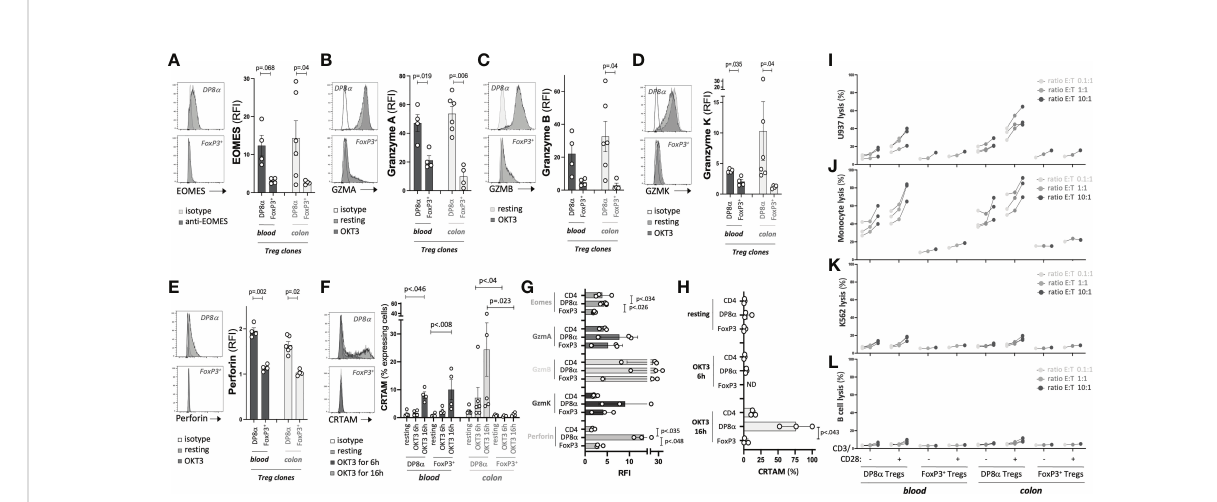
FIGURE 4 DP8 a Tregs can kill myeloid cells. (A , F) Clone expression of EOMES (A) Granzyme A (B) Granzyme B (C) Granzyme K (D) Perforin (E) measured by intracellular labelling following or not activation for 6h and cell surface expression of CRTAM (F) following or not activation for the indicated time. Clones were activated with coated 0.5 m g/ml OKT3. (G, H) PBMCs from 3 HD were OKT3-stimulated for either 6h and stained intracellularly for EOMES, Granzymes A, B, K and Perforin (G) or 6h and 16h and stained for CRTAM (H) . Expression of these proteins is shown for indicated T cell subsets. (I - L) Indicated target cells were co-cultured with blood- and colon-derived DP8 a and FoxP3 + Treg clones (stimulated or not with CD3/CD28 beads) at indicated ratios. Cell death was measured as described in the Methods ’ section. Paired 2-sided t- tests were used for single comparisons, while one-way ANOVA followed by Dunn ’ s multiple comparison tests were performed for 4F-H, p<.05 was considered statistically signi fi